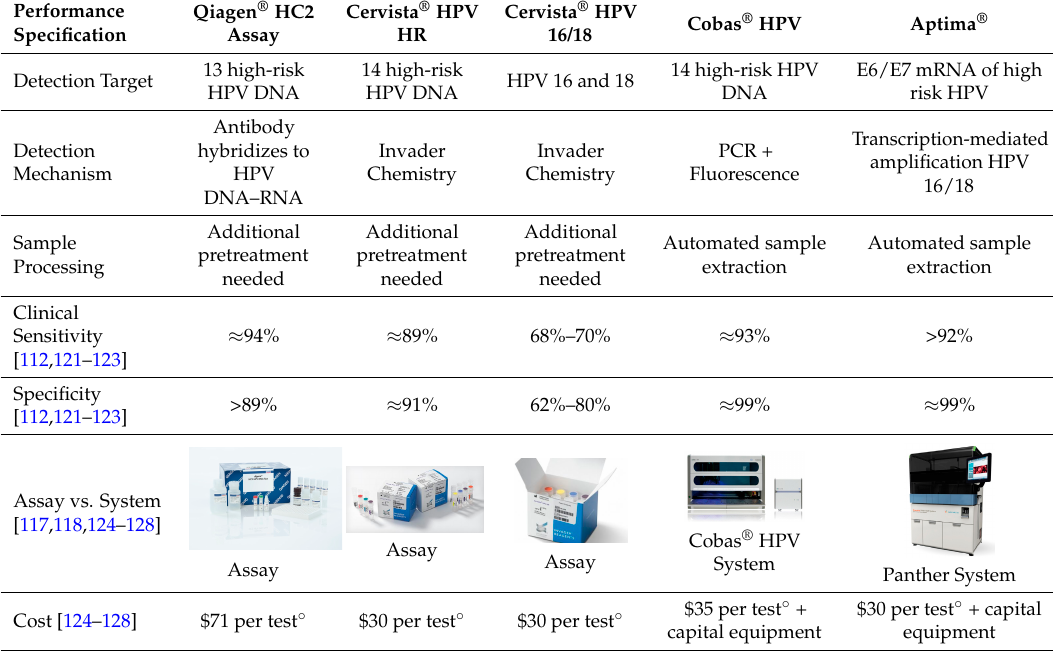
Table 3. Comparison of FDA-approved HPV detection assays [120]. Table 3. Comparison of FDA ‐ approved HPV detection assays [120]. Table 3. Comparison of FDA ‐ approved HPV detection assays Table 3. Comparison of FDA ‐ approved HPV detection assays [120]. Table 3. Comparison of FDA ‐ approved HPV detection assays [120]. Table 3. Comparison of FDA ‐ approved HPV detection assays [120].